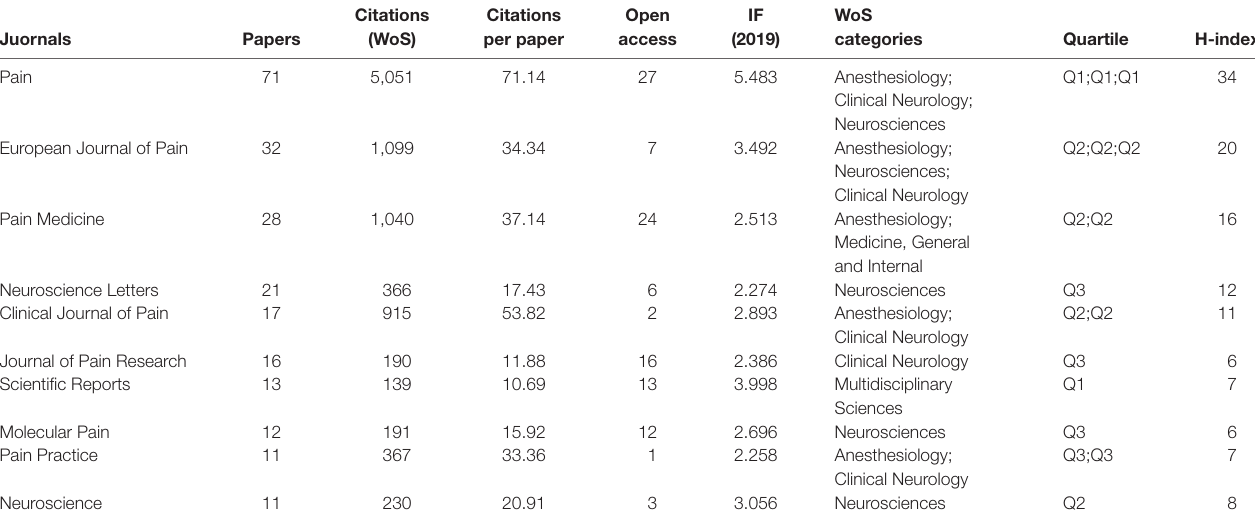
TABLE 1 | The top 10 journals of origin of articles on neuropathic pain associated with anxiety or depression research.